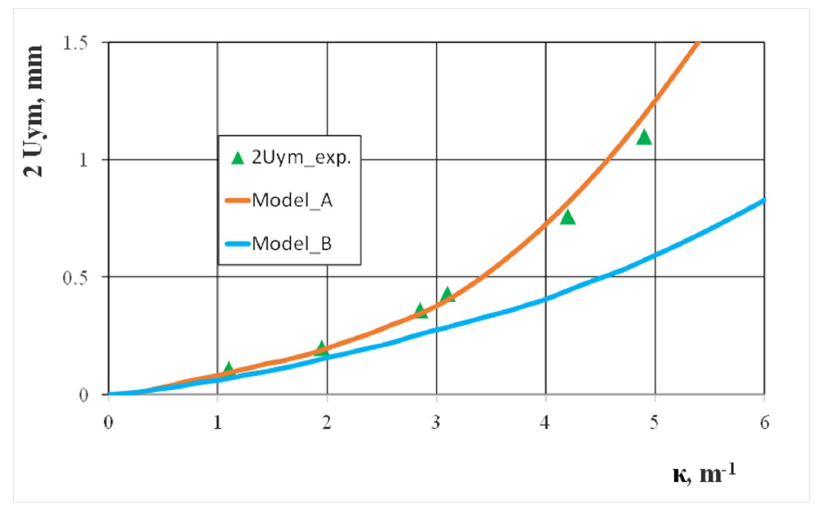
Figure 10. The effect of bending curvature when deflecting the vertical walls of the 25 × 25 × 2 square steel pipe.